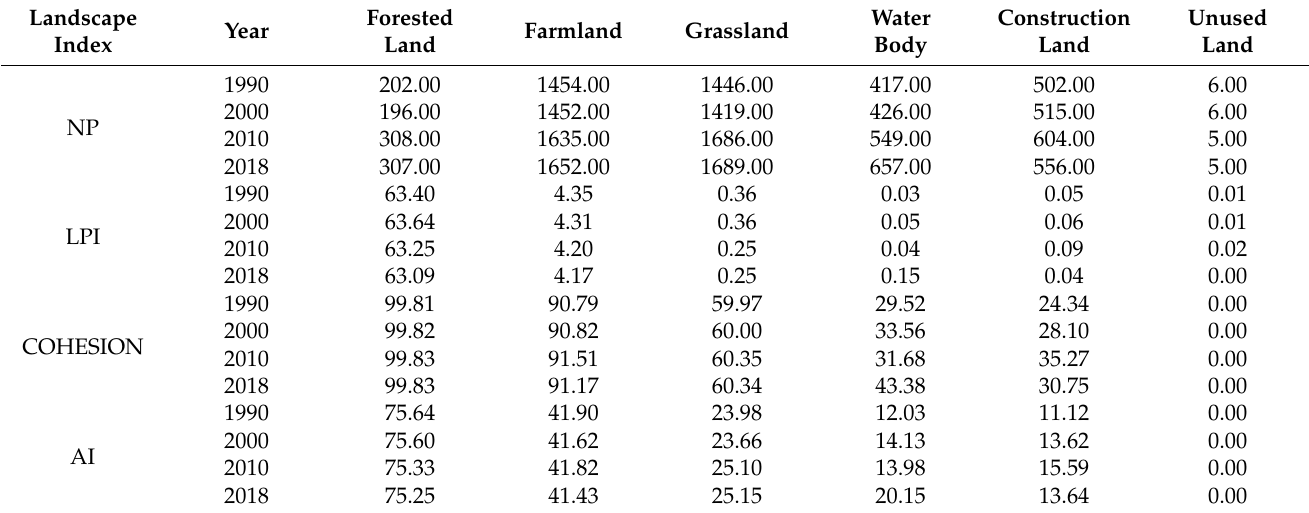
Table 4. Landscape pattern indices at patch type level during 1990–2018 in Guangxi.